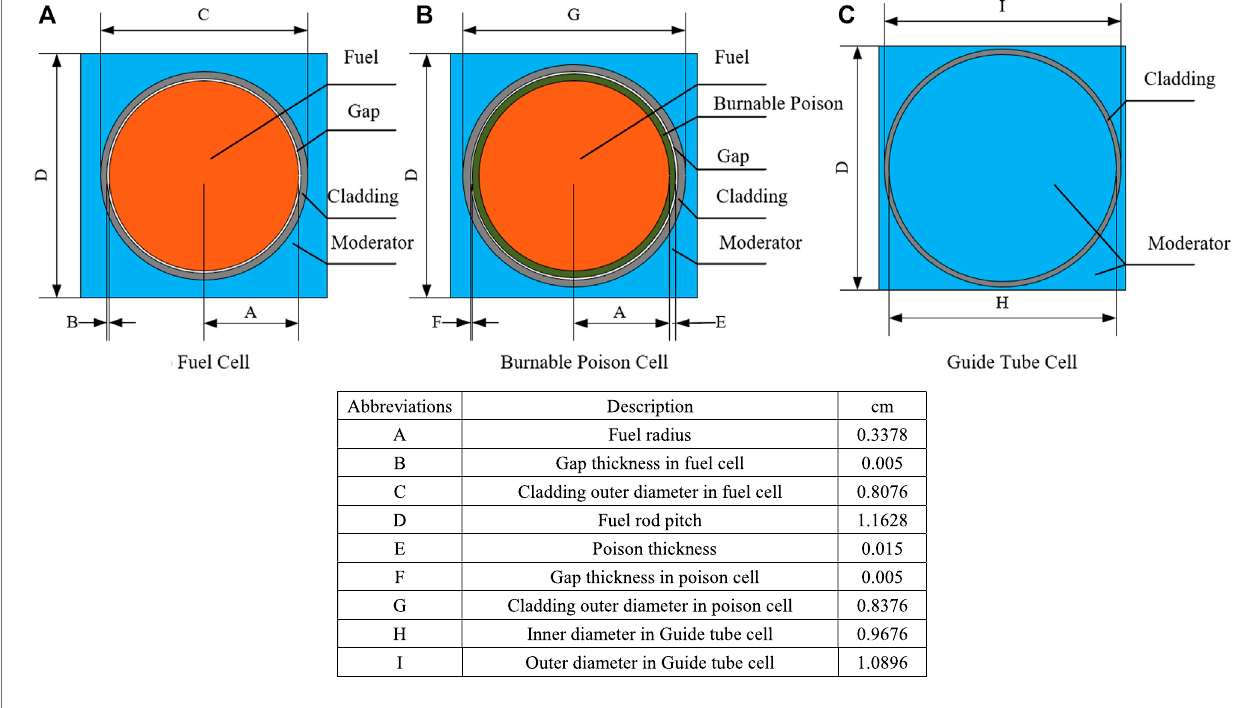
FIGURE 4 | Geometry con fi guration of different